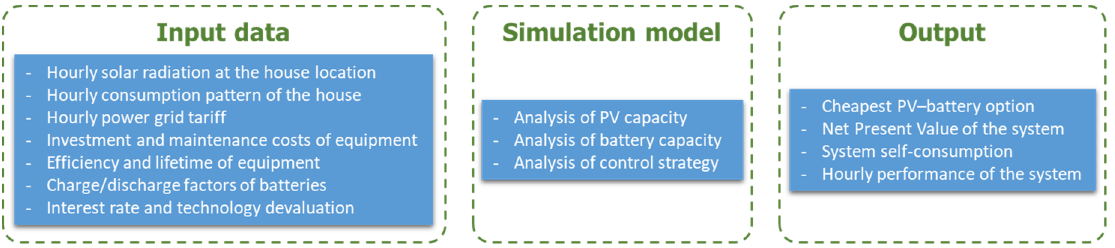
Figure 1. Input data, internal analysis and output of the proposed simulation model.